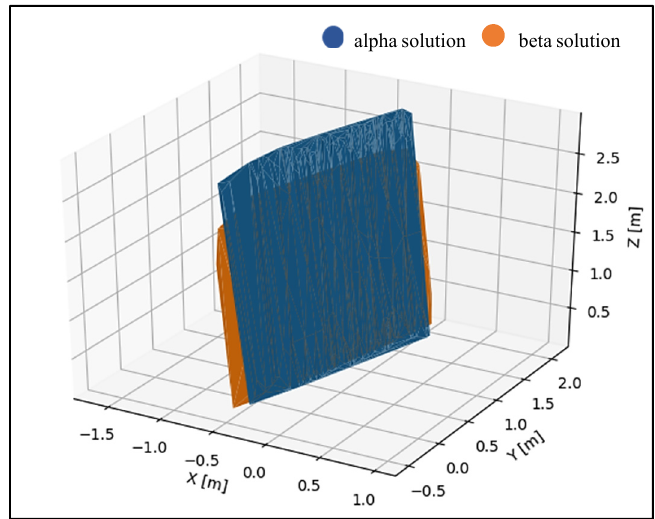
Figure 8 . Precast concrete wall (Msplit fitting result).